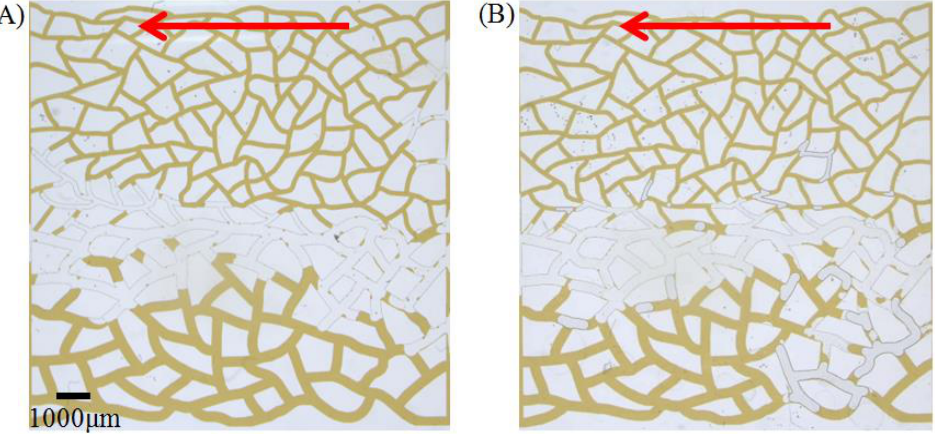
Figure 6. The final state of crude oil displacement of ASB ( A ) and A145 ( B ) solutions in heterogeneous fracture model.